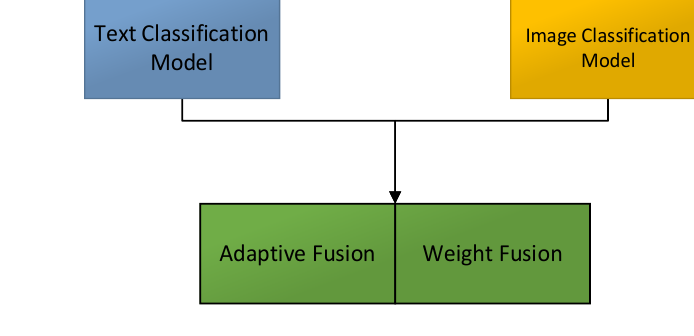
Fig. 4. Structure of fusion model